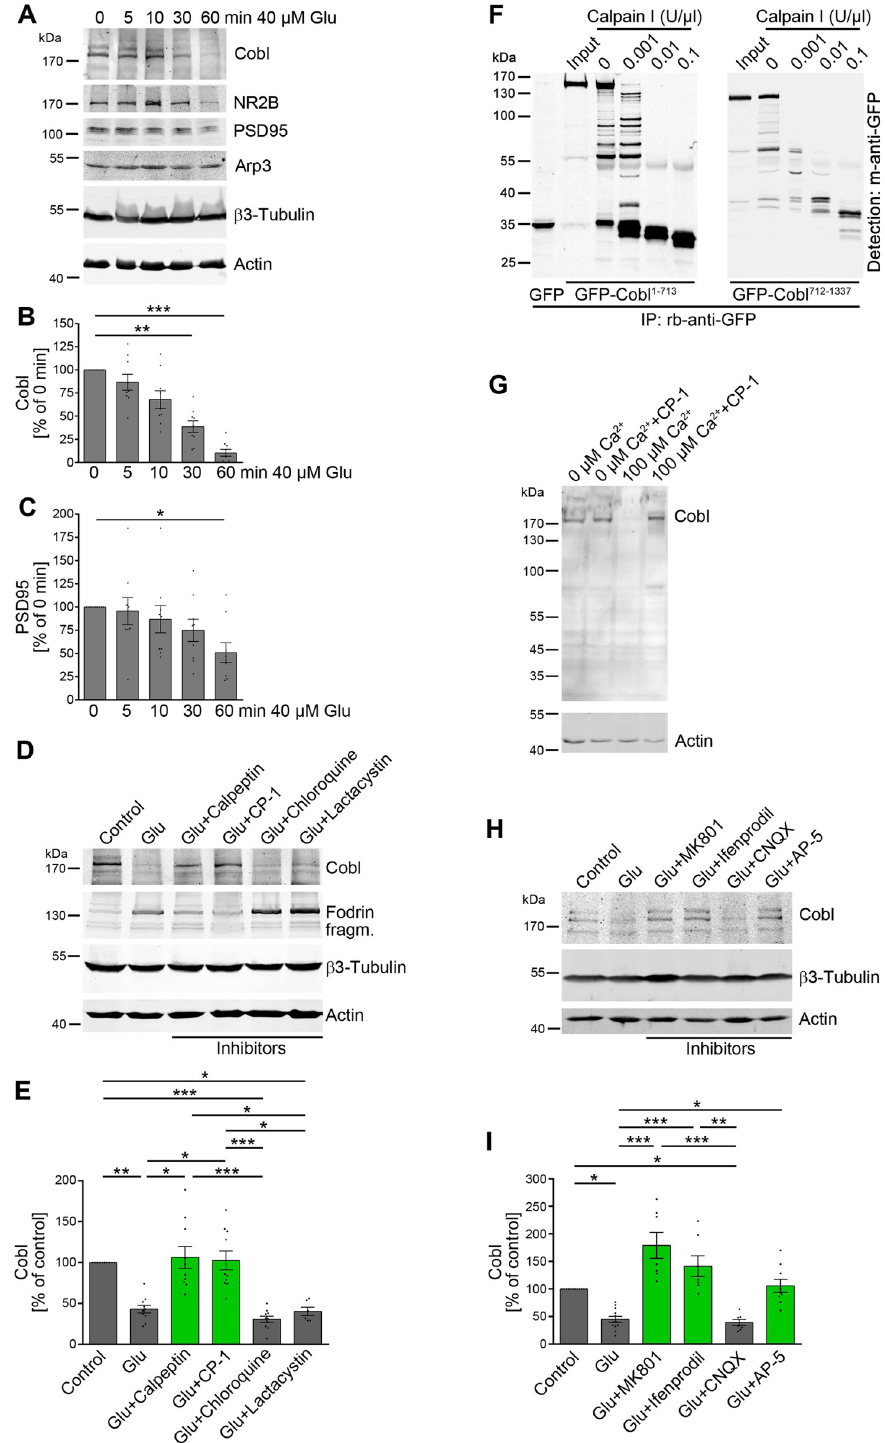
Fig 2. Cobl degradation upon stroke is mirrored by glutamate-induced excitotoxicity brought about by NMDA receptors, high Ca 2+ levels and calpain activity. ( A–C ), Quantitative immunoblotting analyses of cultures of cortical neurons (DIV15) subjected to different durations of incubation with 40 μ M glutamate (Glu). A , Representative blots. B, C , Excitotoxicity-induced decline of anti-Cobl ( B ) and anti-PSD95 ( C ) immunosignals. n = 9 independent assays. D, E Proteolytic pathways underlying the glutamate-induced (30 minutes) Cobl decline, as shown by application of